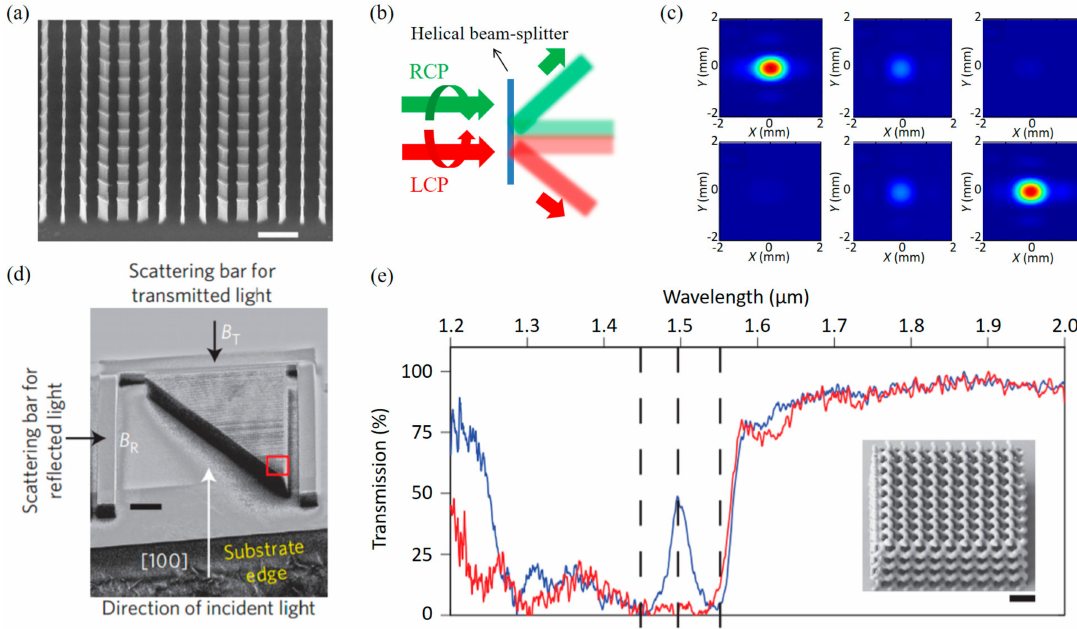
Figure 11. ( a ) SEM image; and ( b ) schematic illustration of helical beam-splitter demonstrated by M. Khorasaninejad and K. B. Crozier [156]. Scale bar, 1 µ m; ( c ) Captured CCD images of diffraction. The first and second rows present LCP and RCP cases. The first, second, and third columns present − 1, zero, and +1 order of diffractions. ( d ) Oblique SEM image of gyroid crystal metamaterial (GCMM) prism [157]. Scale bar, 20 µ m; ( e ) Transmission spectra of GCMM for two different optical handedness. Red and blue lines denote RCP and LCP incidences, respectively. Inset image represents SEM image of the GCMM. Scale bar, 2 µ m. Reprinted by permission from Macmillan Publishers Ltd.: (Nature Communications) (Reference [156]), copyright (2014) and (Nature Photonics) (Reference [157]), copyright